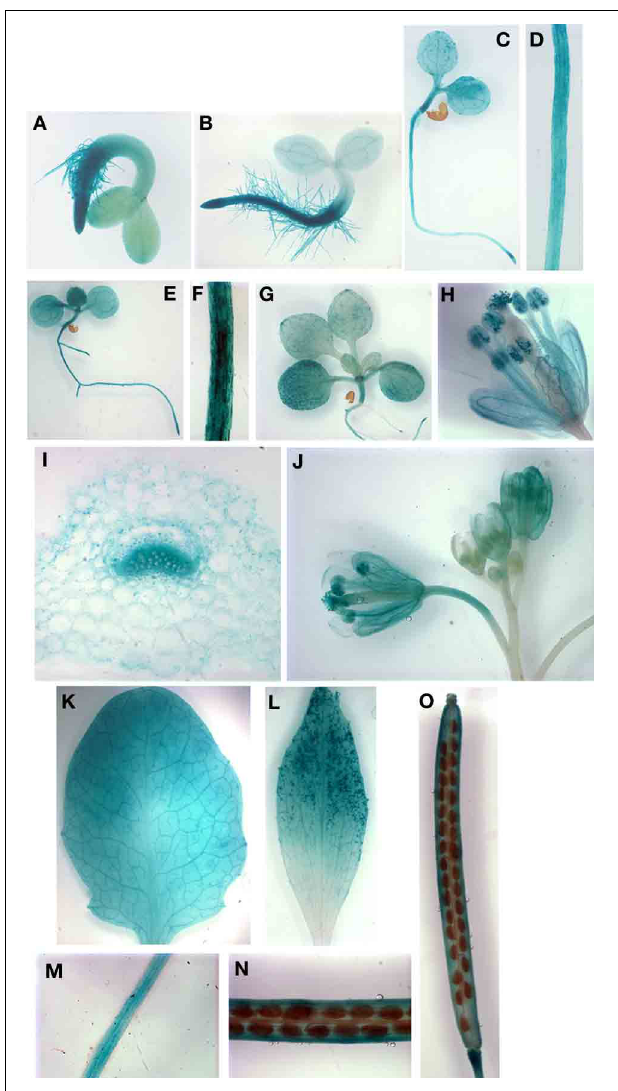
FIGURE 3 | Histochemical staining of AtYSL6 promoter-GUS reporter plants. (A) Seedling at 48h (B) Seedling at 72h (C) Seedling at 5 days (D) Root of 5-day-old seedling (E) Seedling at 8 days (F) Root of 8-day-old seedling (G) Seedling at 11 days (H) Flower at 27 days (I) Cross-section of rosette leaf at 27 days (J) Flowers at 24 days illustrating mature and immature flowers (K) Rosette leaf at 27 days (L) Cauline leaf at 37 days (M) Root at 24 days (N,O) Siliques at 24